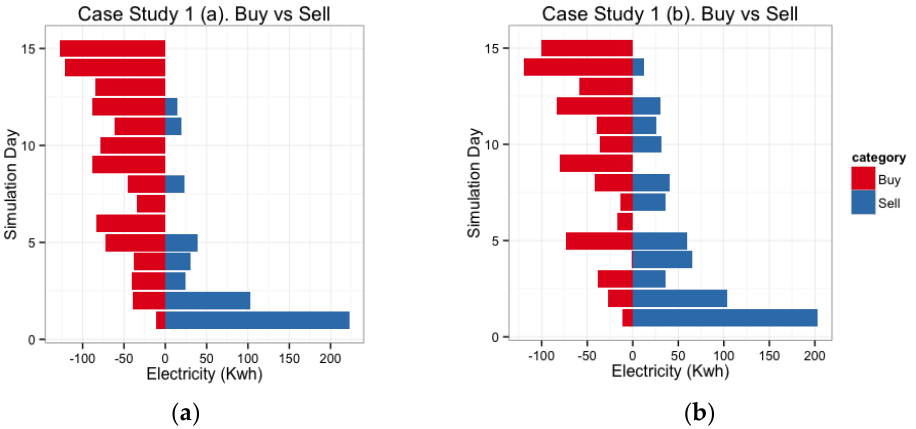
Figure 4. Case Study 1: Electricity purchased vs. electricity sold in scenarios ( a , b ). The diagram on the